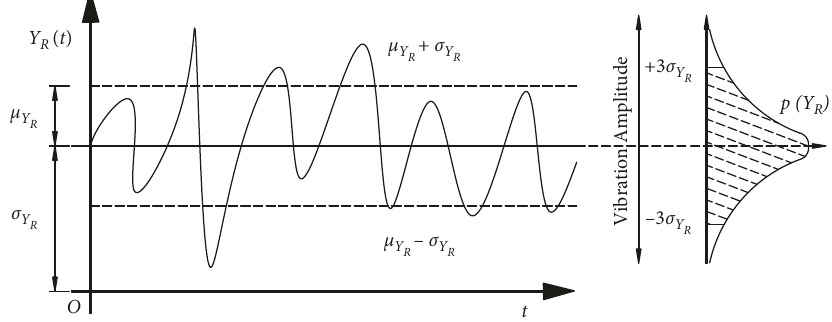
Figure 6: A sample diagram for displacement response of random process Y